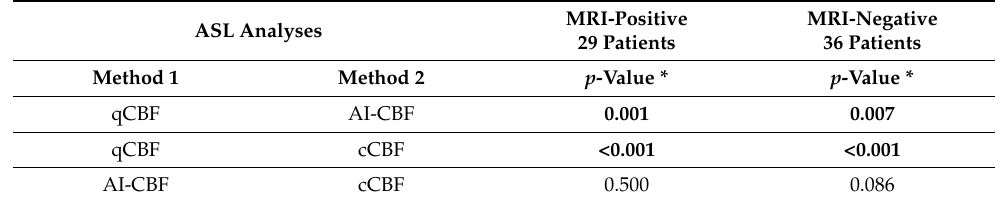
Table 2. Comparison of ASL